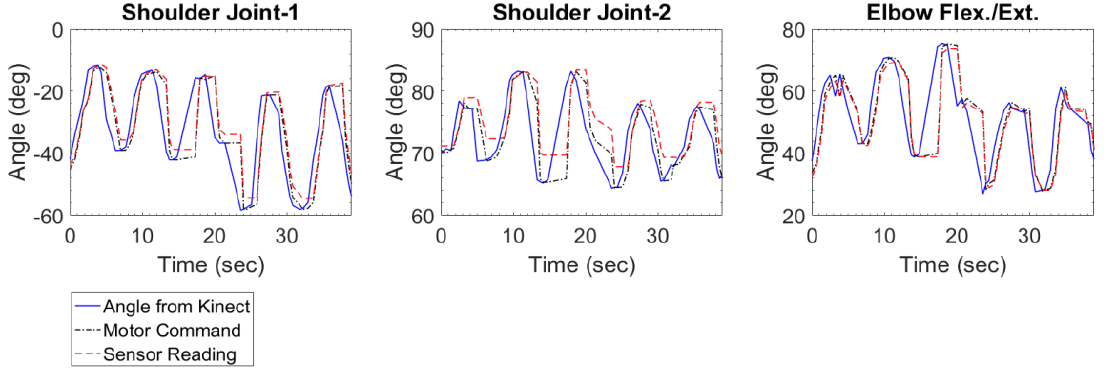
Figure 18: Diagonal reaching teleoperation, comparison between joint angles from Kinect and NAO robot